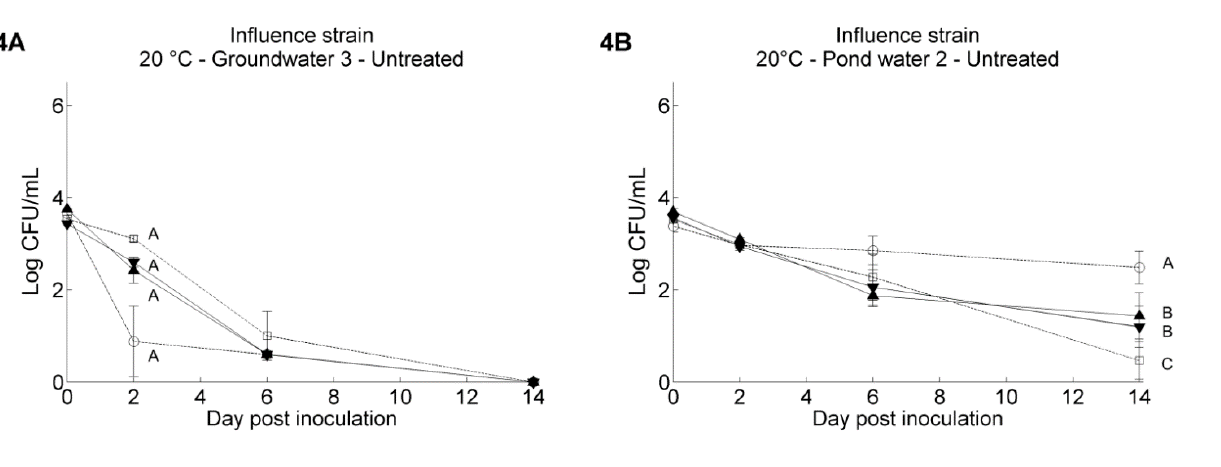
Figure 4. Survival of Salmonella Typhimurium MB4880 (  ), Salmonella Thompson RM1987N (  ), E. coli O157:H7 MB3885 (□) and E. coli O157:H7 NCTC12900 (○) in untreated irrigation water stored at 20 °C. Pathogen suspensions in ( A ) groundwater 3; ( B ) pond water 2. The data show the mean of three analyzed vials and are calculated from the log transformed values of the pathogen population size. Error bars indicate standard deviations. Different letters indicate significant difference ( p < 0.05) between means according to negative binomial regression.